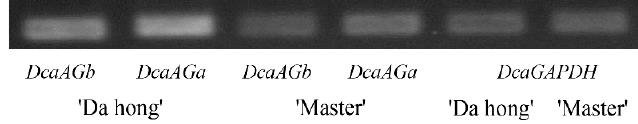
Figure 4. Semi-quantitative PCR (sq-PCR) analysis of two DcaAG genes in single and double flower phenotype carnations. The expression of both DcaAG genes in the double flower phenotype carnation were lower than that in the single flower phenotype carnation.